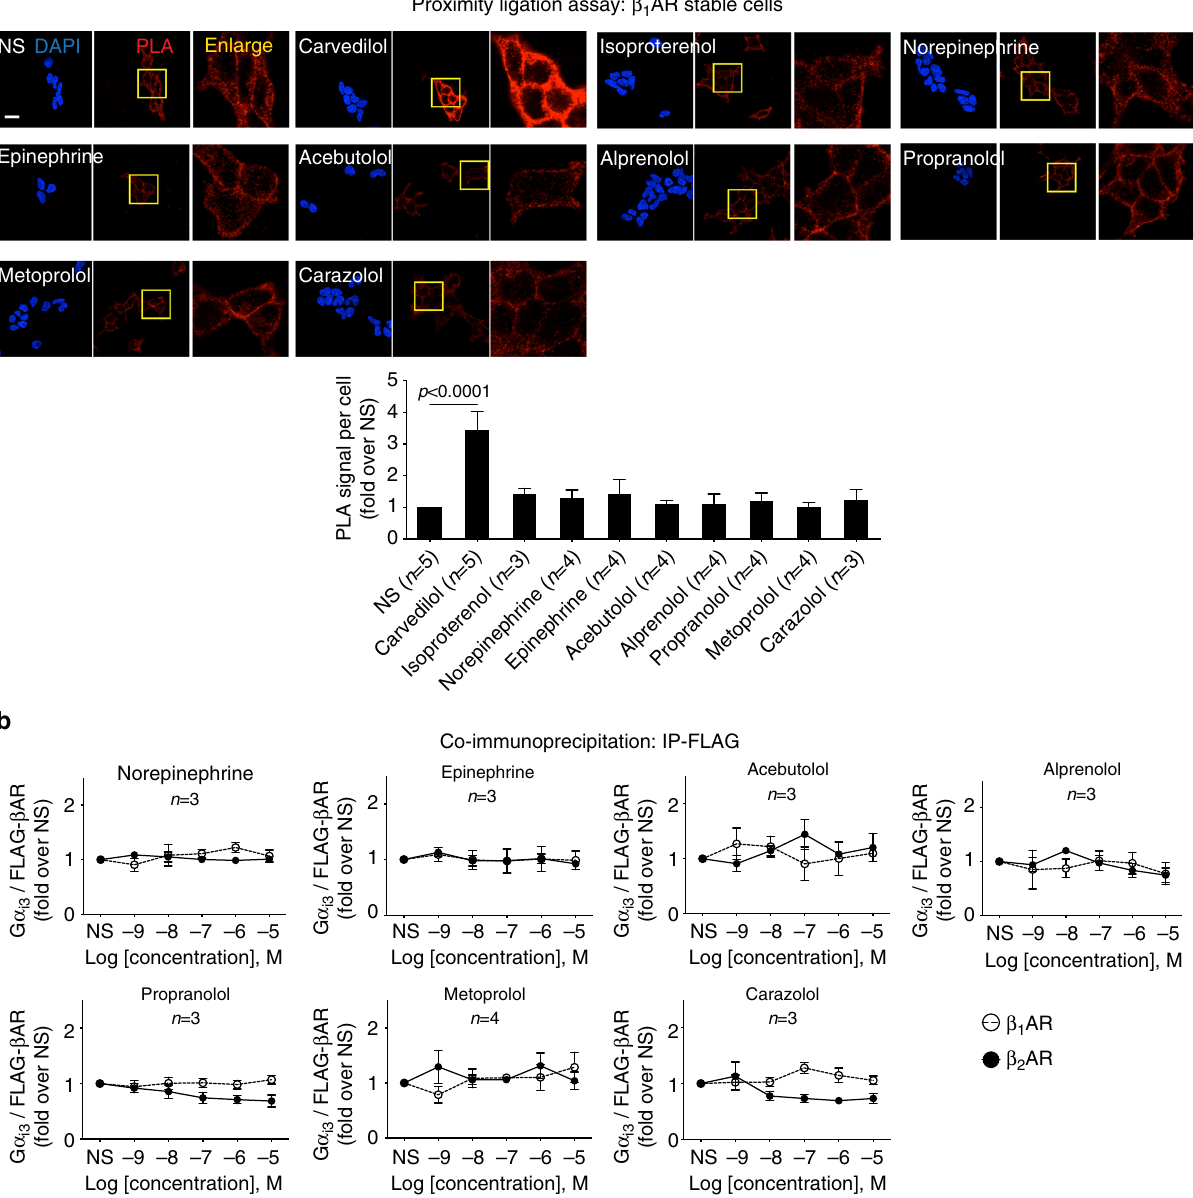
Fig. 4 A number of β AR agonists or antagonists tested do not have signi fi cant effect on G α i recruitment. a β 1 AR stable cells were stimulated with vehicle or 10 μ M indicated ligands for 5 min. Interaction of β 1 AR and G α i were detected by PLA. Scale bar = 20 μ m. b β 1 AR or β 2 AR stable cells were stimulated with ligands at indicated concentration for 5 min. G α i recruitment was detected by co-immunoprecipitation. Both assays suggested that none of the ligands tested had similar effect of carvedilol on G α i recruitment. Data represent the mean ± SEM for n independent experiments as marked on the fi gure. Statistical signi fi cance vs. unstimulated cells was assessed using one-way ANOVA with Bonferroni